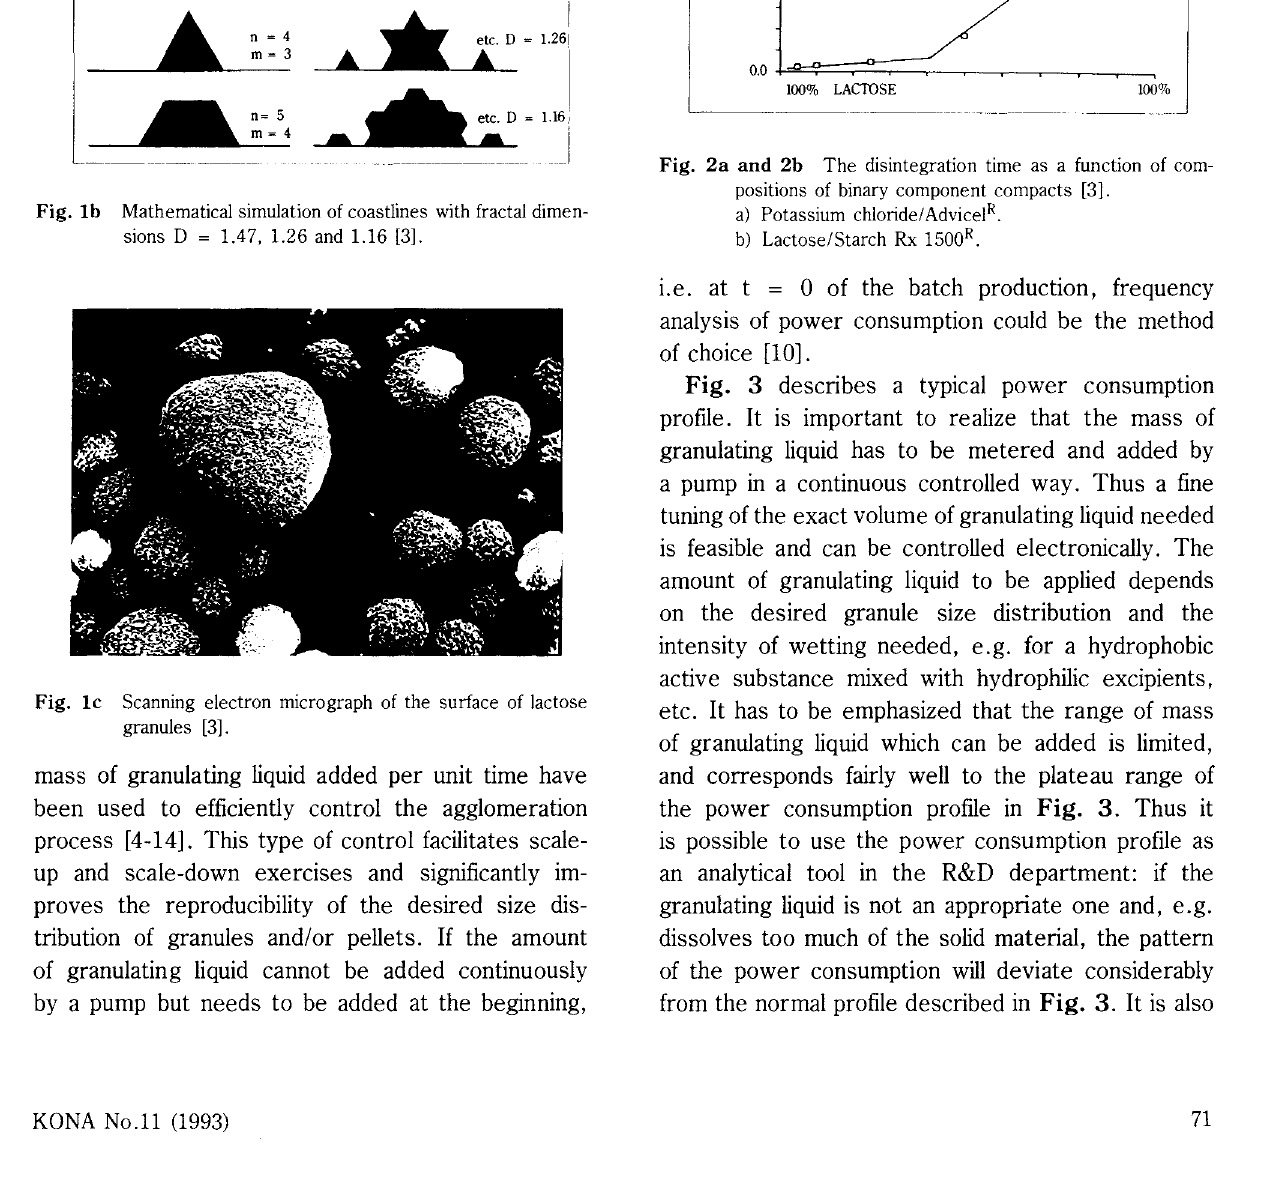
Fig. la An outline of the surface roughness of a lactose granule [3]. Coastline of a lactose granule with linear fractal dimension D = 1.091 ± 0.007.